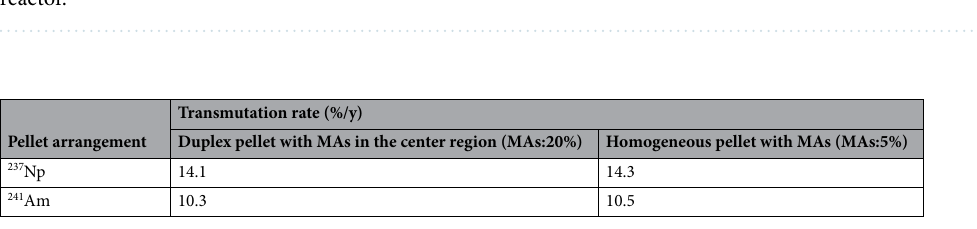
Table 5. Characteristics of sodium void reactivity and Doppler coefficient in the core of the fast breeder reactor.